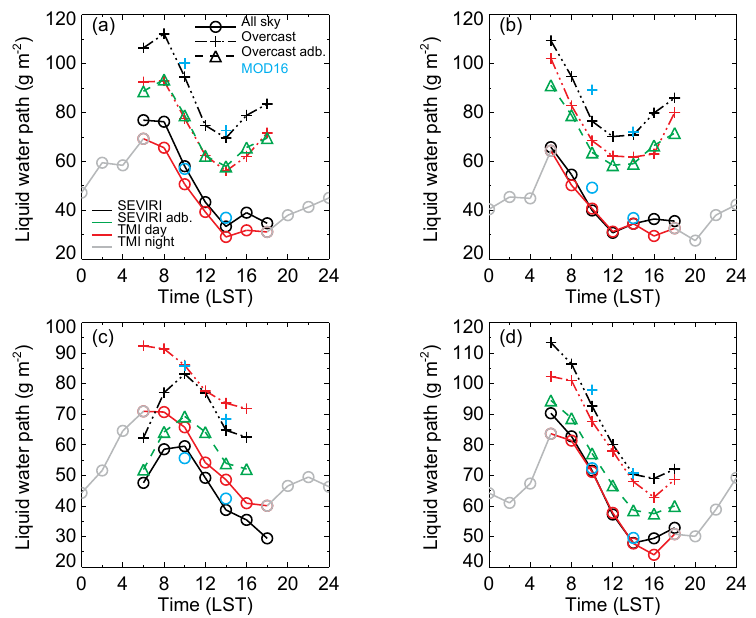
Figure 11. Seasonal-mean diurnal cycle of SEVIRI and TMI LWPs over the Sc region, both for all-sky and overcast (LCF ≥ 95% and τ > 3) cases: (a) DJF, (b) MAM, (c) JJA, and (d) SON for December 2010 to November 2012. MODIS Terra and Aqua values are also plotted. Rain-, ice-, and smoke-free conditions were